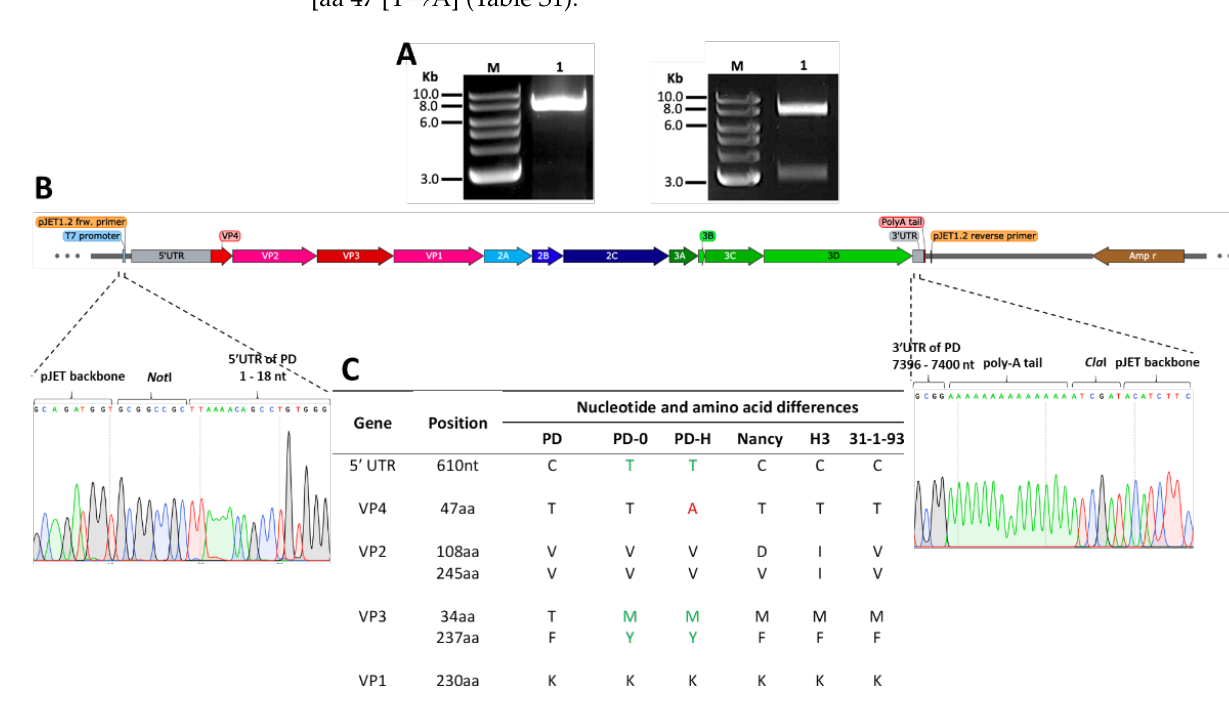
Figure 1. Construction of cDNA plasmid clone pJet-CVB3-PD-H. ( A ) Viral RNA isolated from PD-0 was reverse transcribed and full-length cDNA was amplified by PCR. Left image: a ∼ 7.5 kb long final product was confirmed on agarose gel. Lane M; 1-log DNA ladder, Lane 1; amplified cDNA from PD-0. Right image: cDNA from PD-0 was extracted from the gel and inserted into the pJET1.2/blunt cloning vector. The resulting plasmid pJET-CVB3-PD-H was digested with Not I and Cla I restriction enzymes which flank the viral cDNA. Lane M; 1-log DNA ladder, Lane 1 upper band; full length cDNA of PD-0, lower band; vector backbone. ( B ) Schematic presentation of viral cDNA within pJet-CVB3-PD-H. Chromatograms obtained from Sanger sequencing confirmed the correct orientation of the viral cDNA in the plasmid pJET1.2 backbone. Left sequence chromatogram represents the junction of the pJET1.2 backbone and cDNA of PD-0 with the first 17 nucleotides of the 5′-UTR region of the viral cDNA. Right chromatogram represents the junction of the pJET1.2 backbone with the 3′ terminus of the 3′-UTR region of cDNA of PD-0 with the poly-A tail. ( C ) Nucleotide sequence comparison of the viral 5‘-UTR and aa sequence comparison of the viral proteins VP1 to VP4 of different CVB3 variants. Note, the cDNA clone of PD-0 is named PD-H. PD (Genbank accession number: AF231765), 31-1-93 (Genbank accession number: AF231763), Nancy (Genbank accession number: M16572.1), H3 (Genbank accession number: U57056). Green letters: differences between PD-0 and PD-H and other CVB3 variants. Red letters: Difference in aa sequence between PD-0 and PD- H.